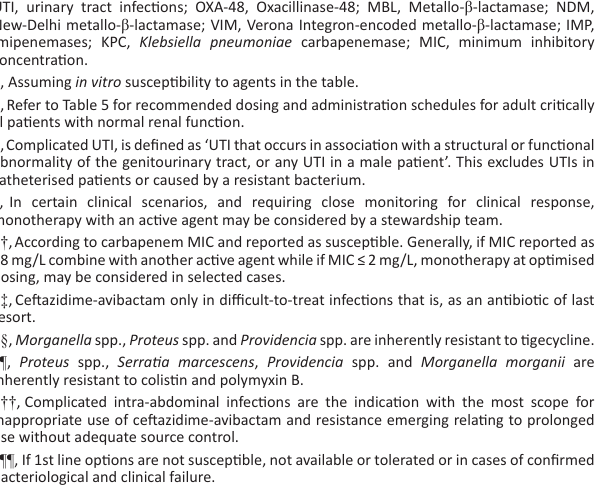
BLICs: β -lactam β-lactamase inhibitor combinations. † , Maximum dosing to account for pharmacokinetic disturbances in this population and to target the upper end of clinical breakpoints. ‡ , Subsequent doses and dosing interval should be based on pharmacokinetic evaluation and use of therapeutic drug monitoring. § Typically, maintenance doses are begun 30 min – 1 h following administration of the loading dose. ¶ , Doripenem at standard doses has no advantage over group 2 carbapenems for susceptible Gram-negatives. ‡‡ , Polymyxin B, unlike colistin, is administered in its active state and not as a prodrug. Hence it has superior pharmacological properties with less pharmacokinetic variability